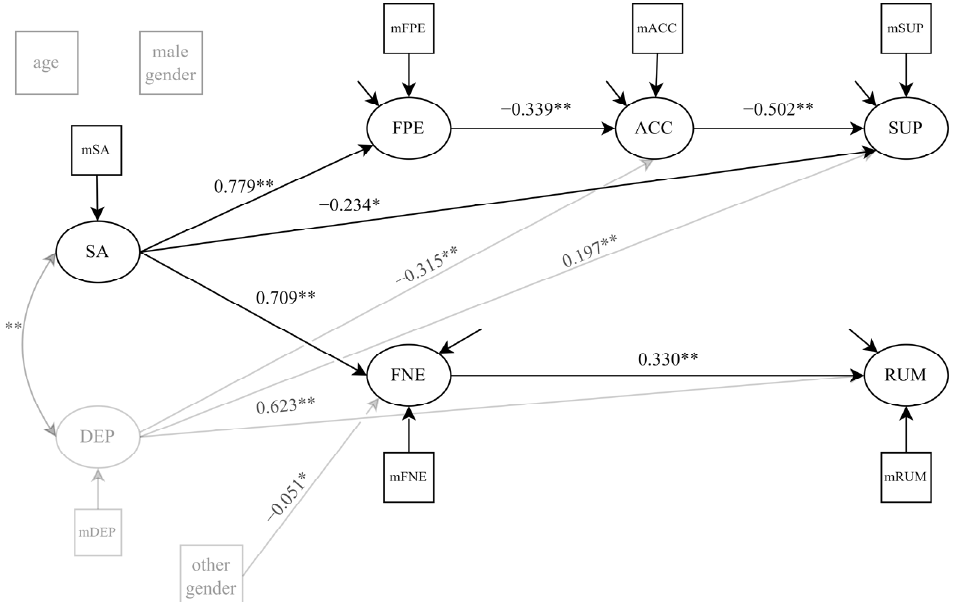
Figure 2. Structural equation model with standardized path coefficients. Control variables are displayed in grey. Non-significant paths are not shown. * p < 0.05; ** p < 0.01. SA = social anxiety; FPE = fear of positive evaluation; FNE = fear of negative evaluation; SUP = suppression; ACC = acceptance; RUM = rumination; DEP = depressive symptoms.